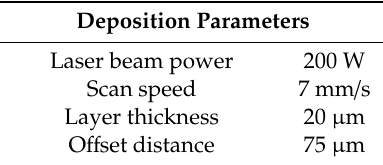
Table 1. Summary of applied selective laser melting (SLM) deposition parameters.